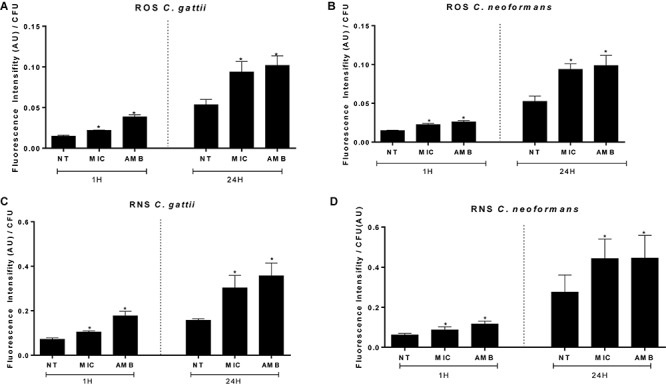
Amounts of reactive oxygen (A,B) and nitrosative (C,D) species peroxynitrite induced by EAF and AMB (positive control) against Cryptococcus gattii
(A–C) and Cryptococcus neoformans
(B–D) within 1 and 24 h. The results are expressed in arbitrary units of fluorescence (AU). Data are represented as the mean ± SEM of two independent experiments in triplicate assays. An asterisk represents statistical differences between the treatments and the control (P < 0.05). EAF, ethyl acetate fraction; NT, no treatment; AMB, amphotericin B; MIC, minimal inhibitory concentration; ROS, reactive oxygen species; RNS, reactive nitrogen species.